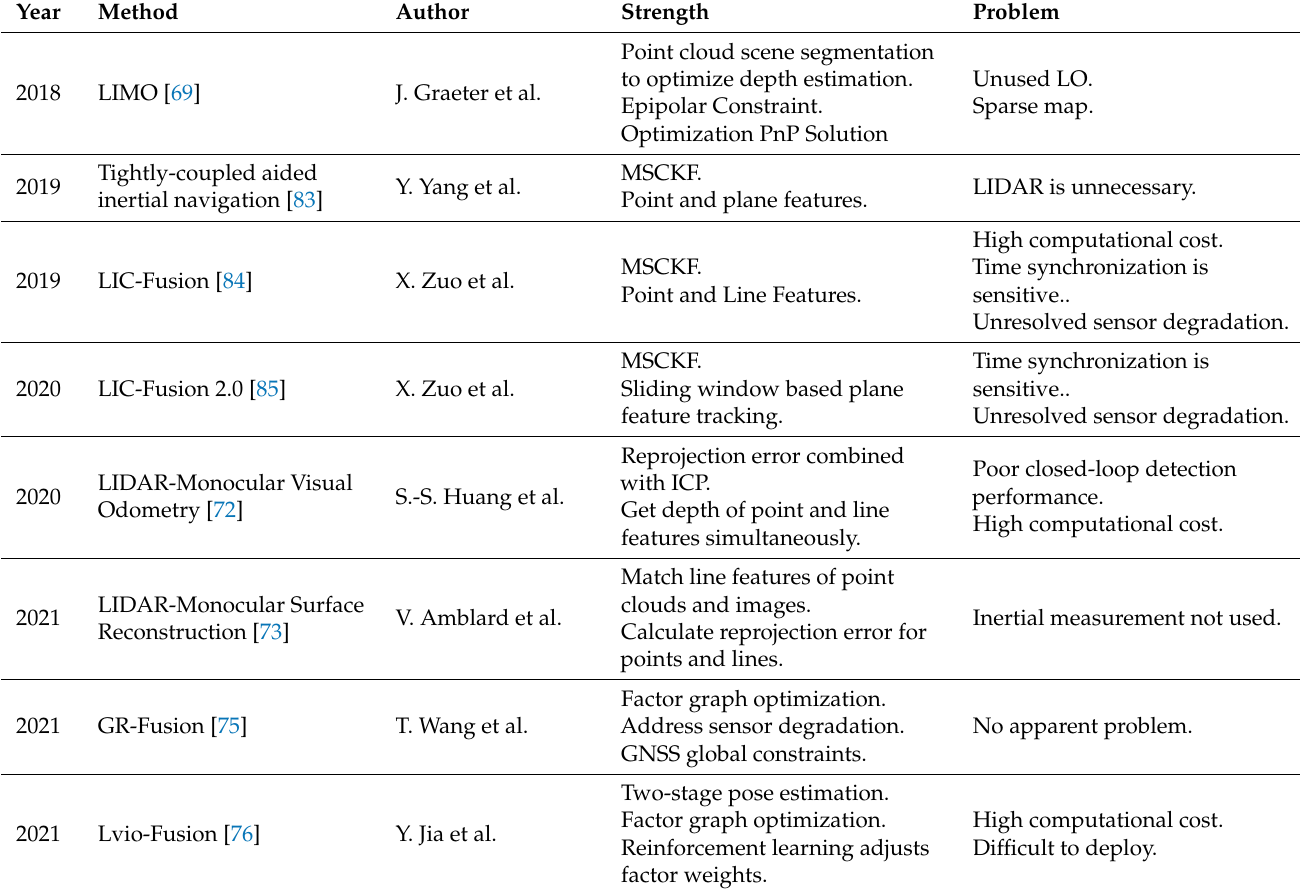
Table 5. LVI Tightly coupled